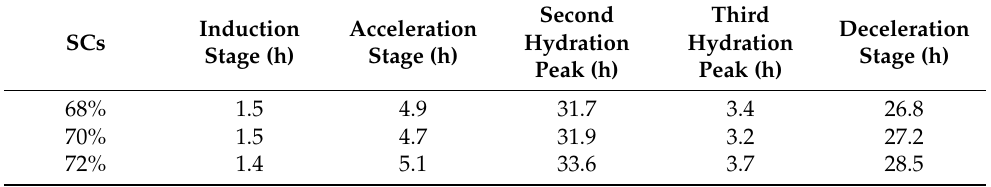
Table 4. Time of hydration exothermic phase of different